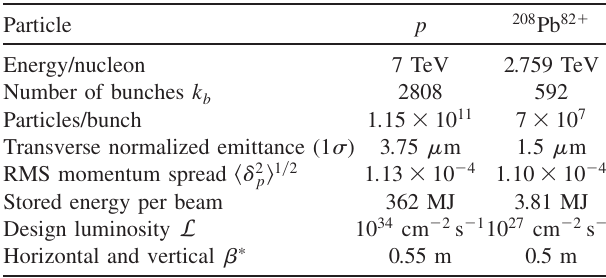
TABLE I. Design parameters for the LHC’s proton and 208 Pb 82 þ beams in collision conditions [1]. The values of L and (cid:2) (cid:4) refer to IP2 for 208 Pb 82 þ ions and IP1 and IP5 for protons (see Fig.